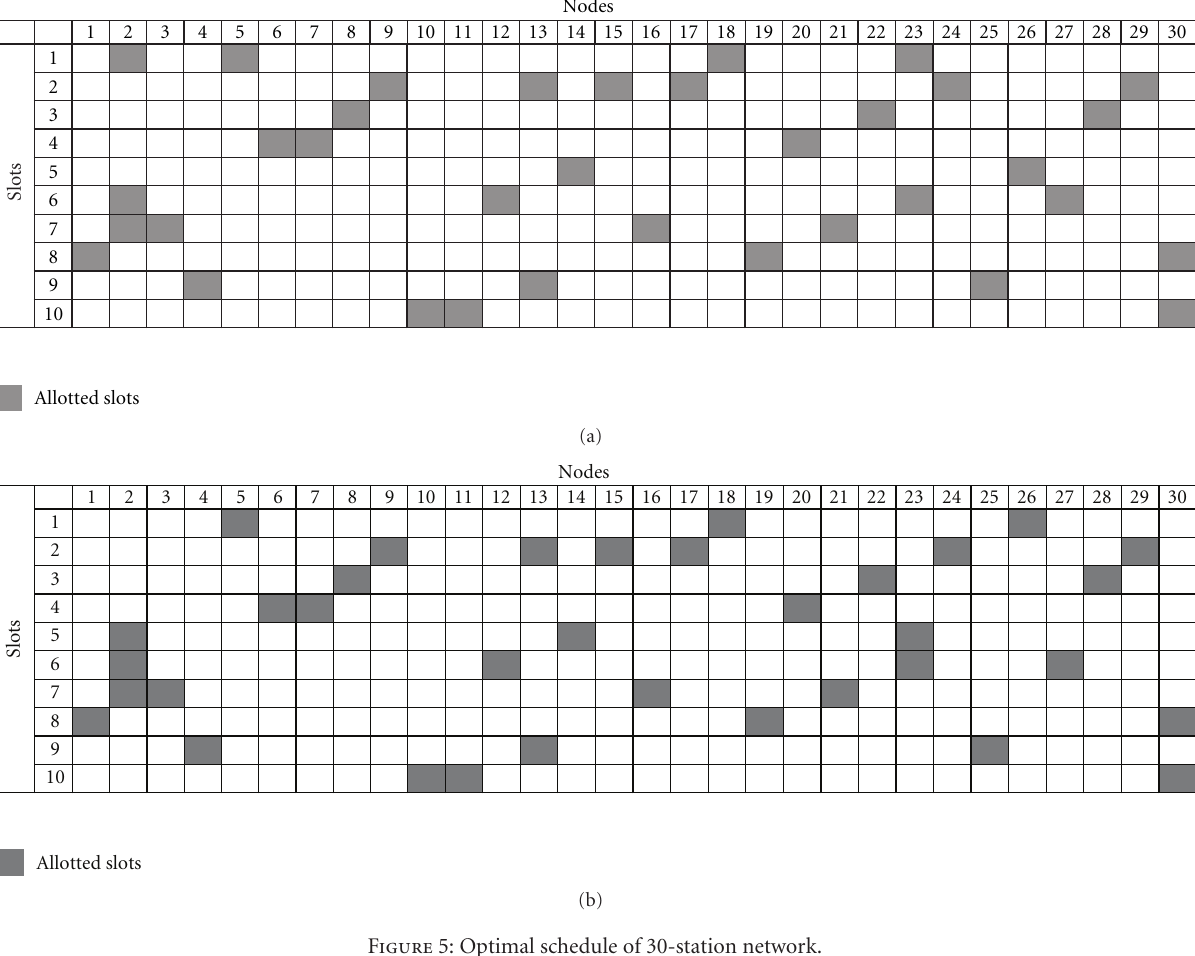
Figure 5: Optimal schedule of 30-station network.